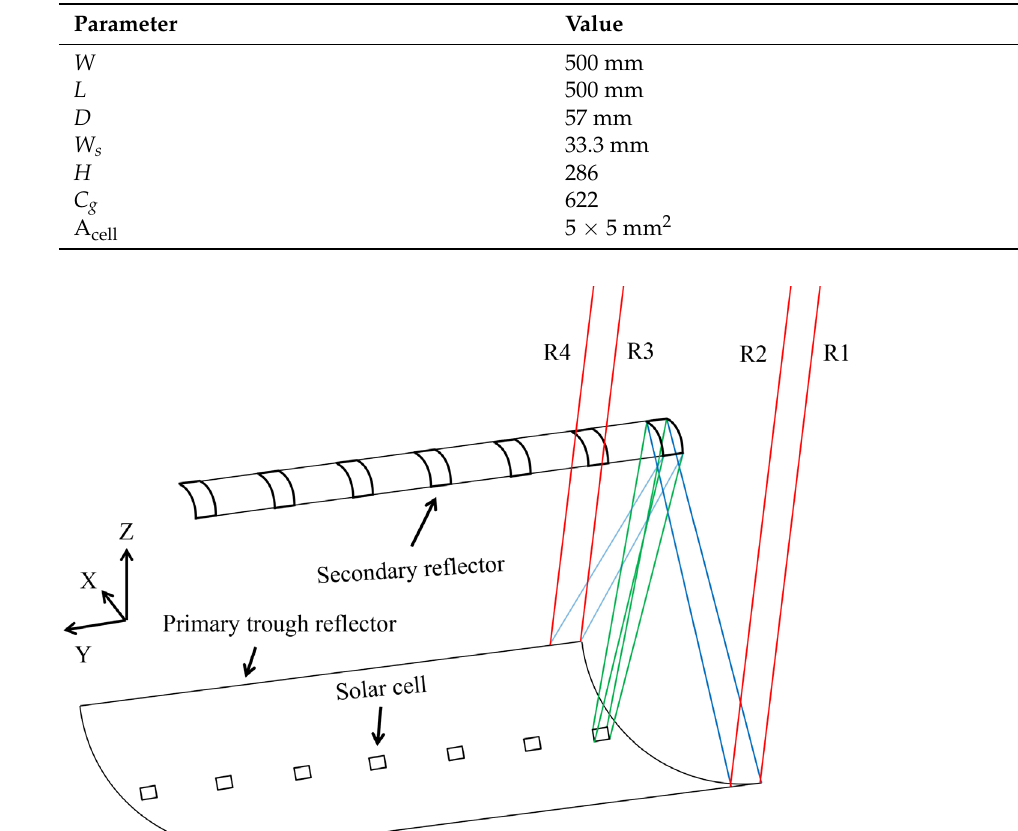
Figure 2. Optical components and their orientation for the HCPV system. Table 1. Design parameters of the optical system.